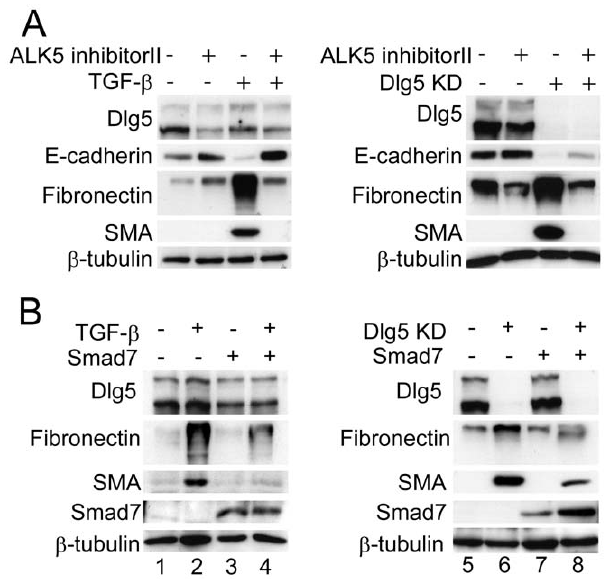
Figure 6. Inhibition of the TGF- b receptor suppresses the expression of mesenchymal marker proteins in Dlg5-depleted cells. A: LLc-PK1 cells were transfected with Dlg5 siRNA (KD) or control siRNA and stimulated with or without 4 ng/ml TGF- b . Two days after the addition of 2 m M ALK5 inhibitor II (TGF- b receptor inhibitor), cells were lysed and immunoblotted using the indicated antibodies. B: LLc- PK1 cells were transfected with a Smad7 expression plasmid or control plasmid and incubated for six hours. The cells were then treated with or without TGF- b (left panel) or transfected with Dlg5 siRNA or control siRNA (right panel). Two days after further incubation, cells were lysed and the expression of the indicated proteins was investigated by immunoblotting. Expression of b -tubulin was detected as a loading control. The results are representative of at least three independent experiments. Both pharmacological and physiological inhibition of TGF- b receptor suppressed the expression of SMA and fibronectin induced in Dlg5-depleted